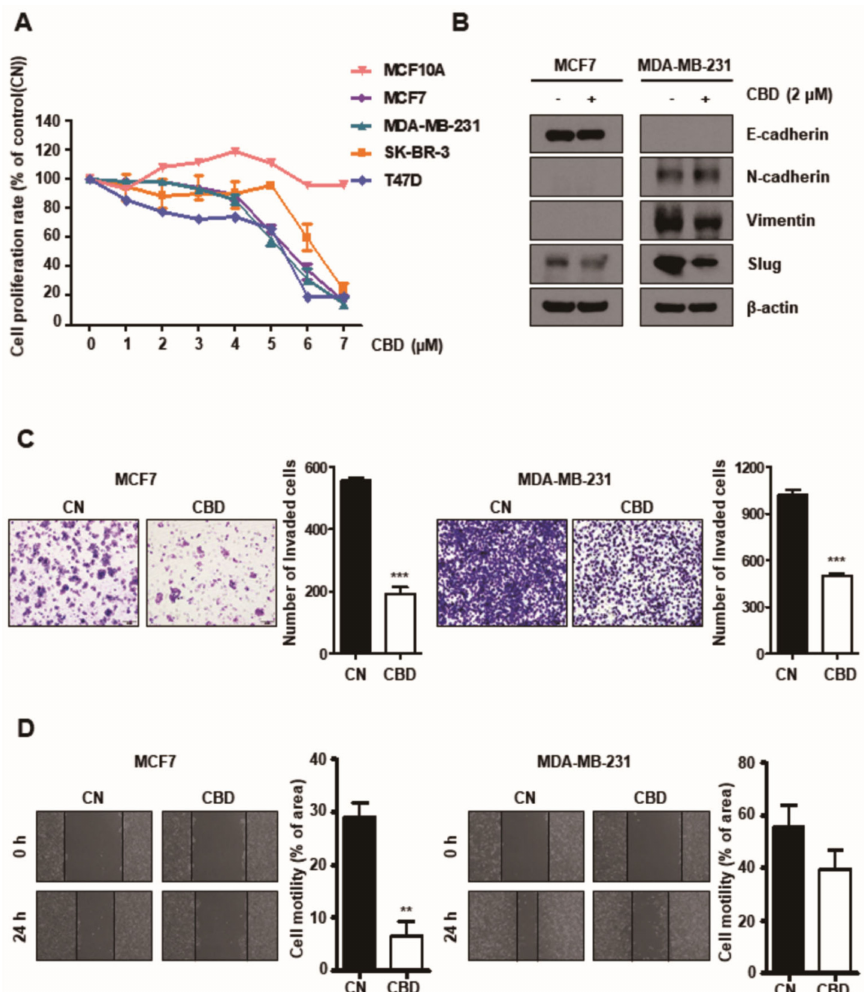
Figure 1. Cannabidiol (CBD) reduces migration and invasion in breast cancer cell lines. ( A ) Breast cancer cell lines and normal cell lines were treated with different doses of CBD for 24 h and assessed using the WST assay. ( B ) Expression of EMT-related proteins was evaluated using Western blotting. β -actin was used as a loading control. ( C ) Cell invasiveness was measured using a Transwell assay with Matrigel. The invaded cells were stained and visualized using microscopy. *** p < 0.001 ( D ) Cell migration ability was measured by a wound-healing assay. Cells were scratched with pipette tips and then incubated with 0.5% FBS in conditioned media with or without CBD (2 µ M). The percentage of recovered area was quantified using ImageJ. **, p < 0.01 CBD; cannabidiol, CN;